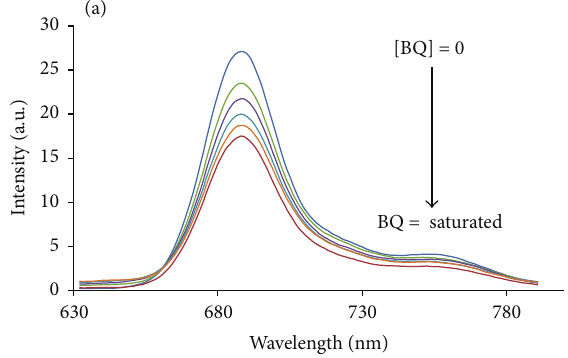
Figure 4: A typical spectrum for the determination of singlet oxygen quantum yield. This figure was for complex 1b (a) in THF at a concentration of 6 × 10 −6 moldm −3 .